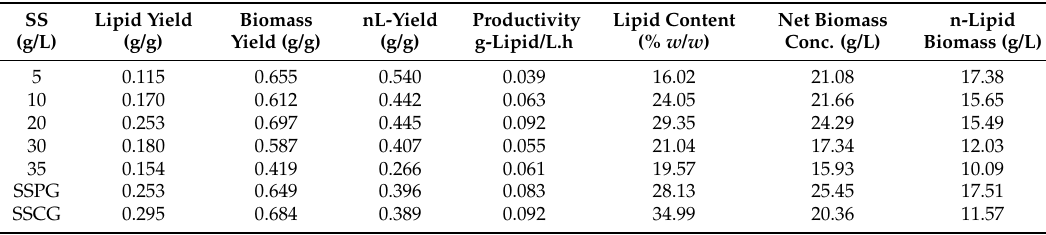
Table 6. Summary of lipid yield, biomass yield, productivity, lipid content, and biomass concentration of this